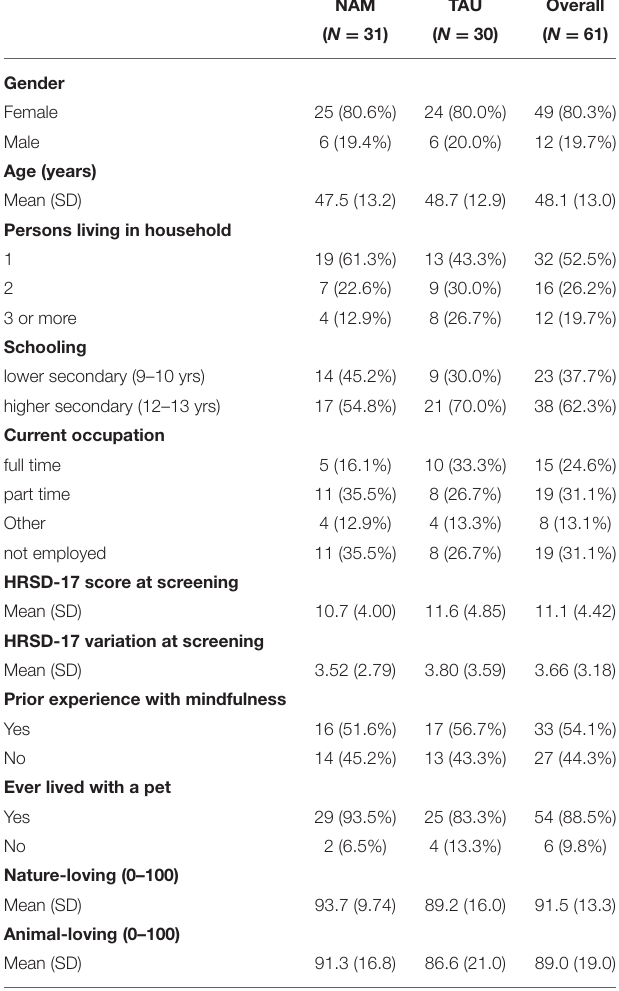
TABLE 2 | Participant